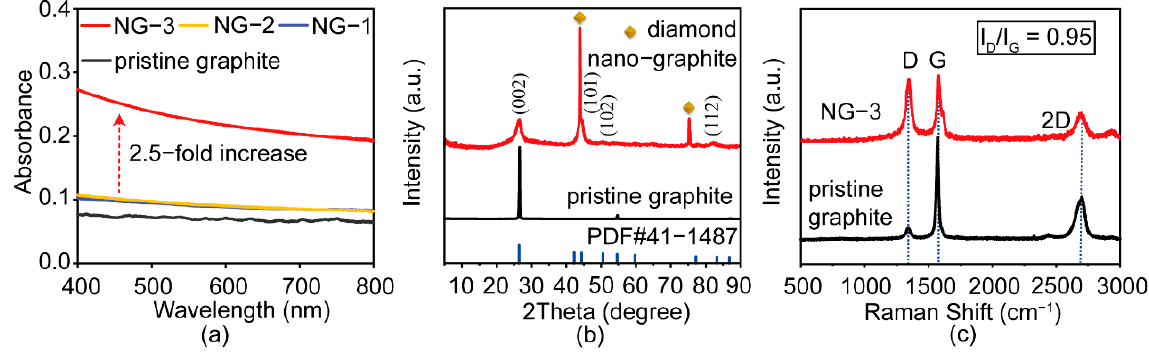
Figure 1. ( a ) UV–vis absorption spectrum for the supernate of pristine graphite and as-exfoliated NG-1, NG-2, and NG-3 after centrifugation. ( b ) XRD patterns and ( c ) Raman spectra of powder sample of pristine graphite and NG-3.